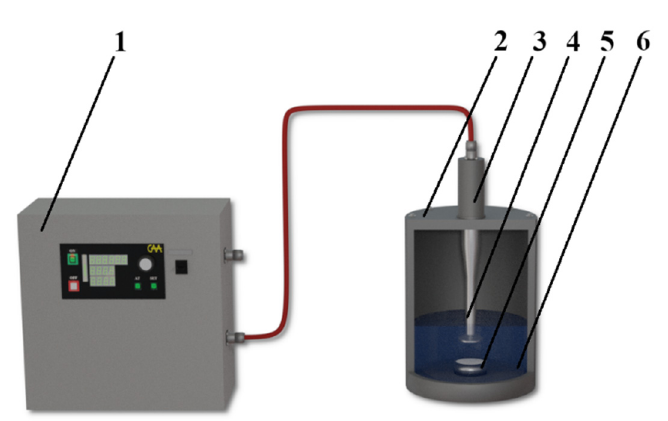
Figure 1. Experimental setup for coating the fabric surface with nanoscale particles: 1—ultrasonic generator; 2—treatment vessel; 3—magnetostrictive transducer; 4—waveguide system; 5—a special frame with fixed fabric sample; 6—suspension of nanoparticles.